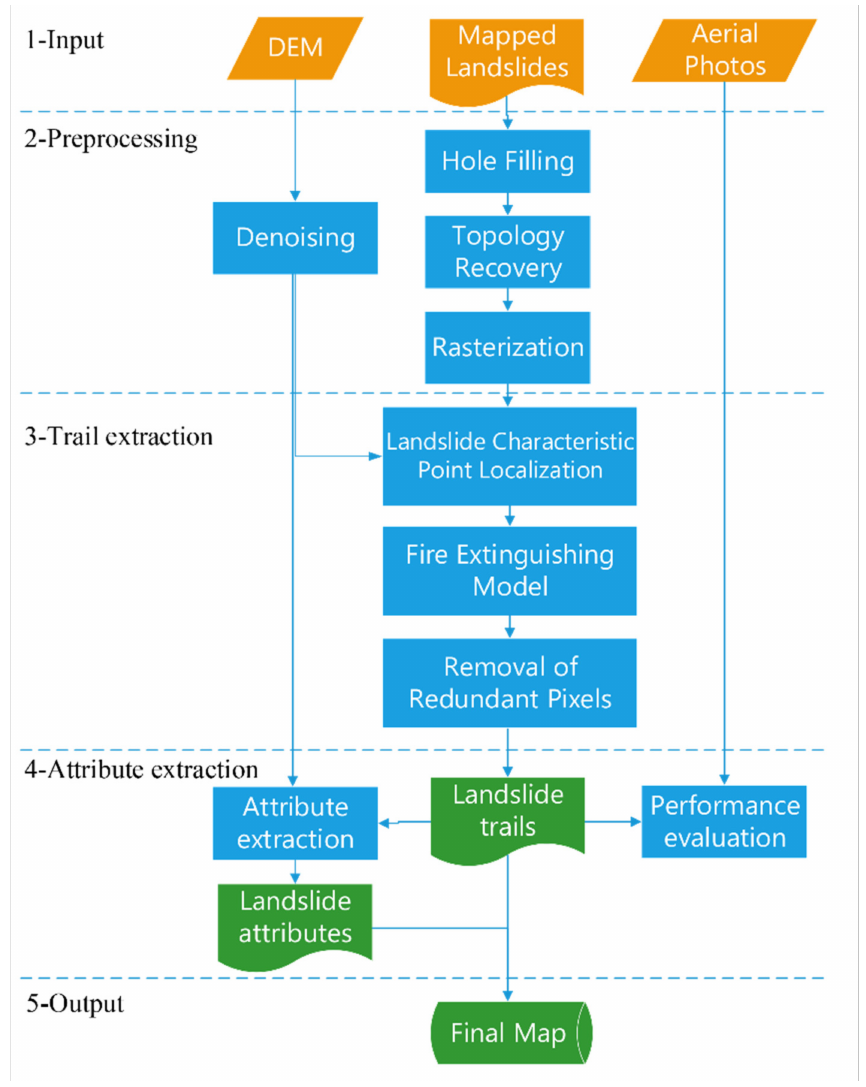
Figure 1. Overall workflow of the proposed landslide extraction